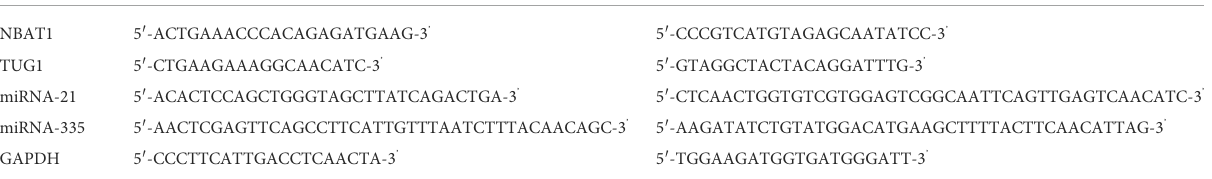
TABLE 1 The primer sequences used for qRT-PCR.